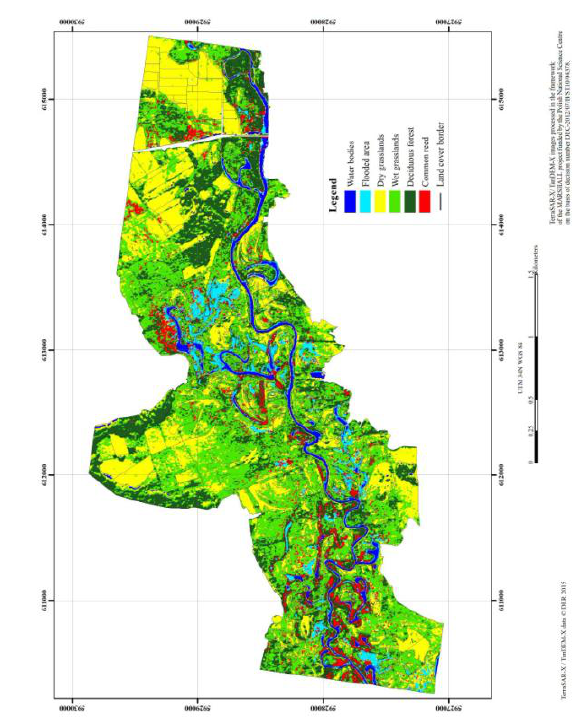
Figure 4. Thematic classification of AOI with Yamaguchi decomposition.